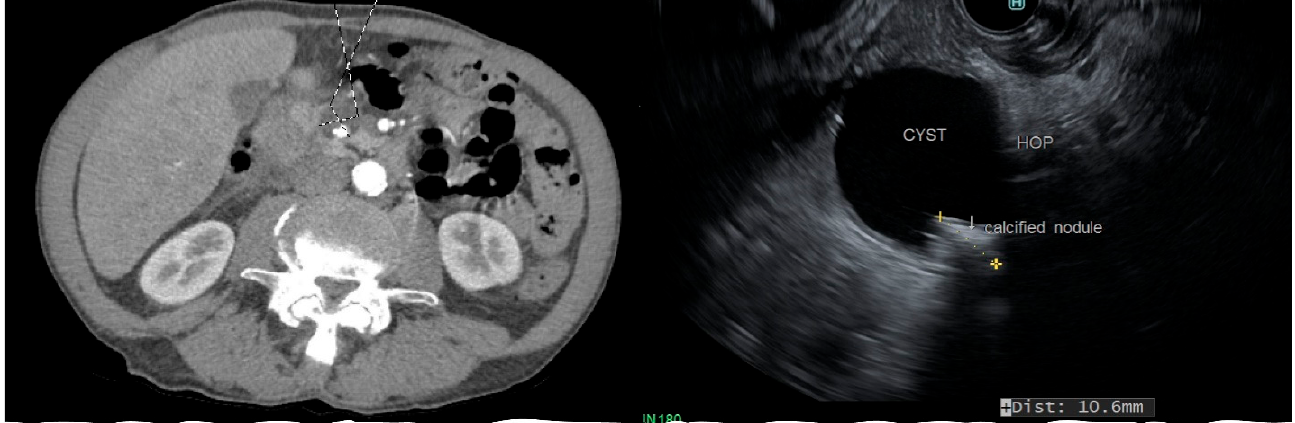
Figure 2. CT scan and endoscopic ultrasound demonstrating a side-branch IPMN involving the head of pancreas (HOP) with a calcified mural nodule.